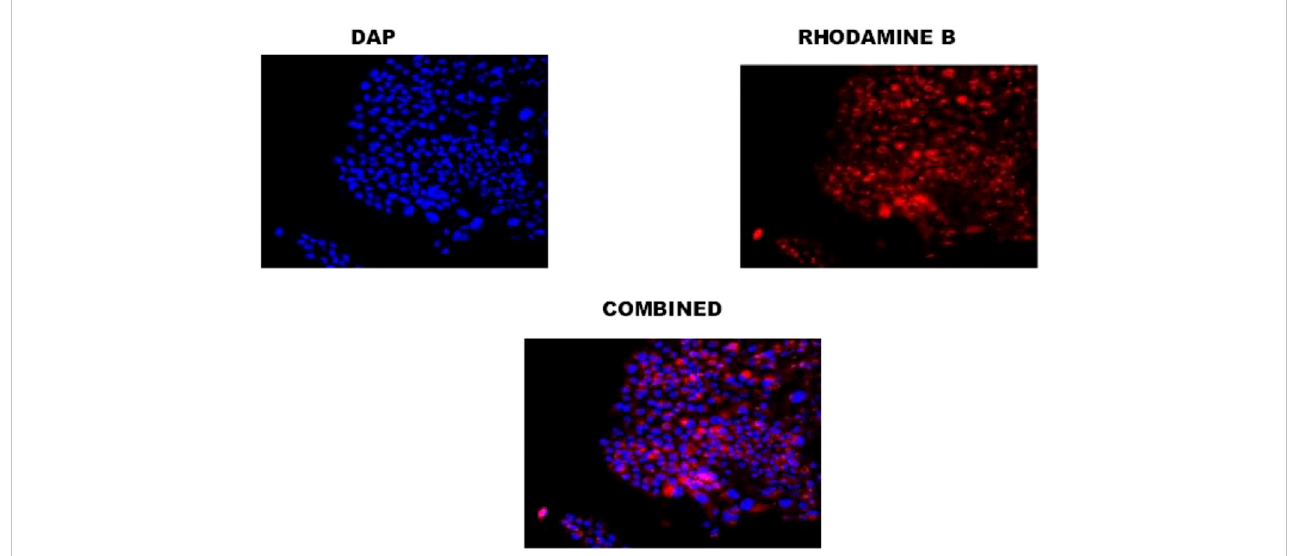
FIGURE 7 Confocal image of cellular uptake studies of TNBC cells after incubating with PLGA-TQ nanoparticles.